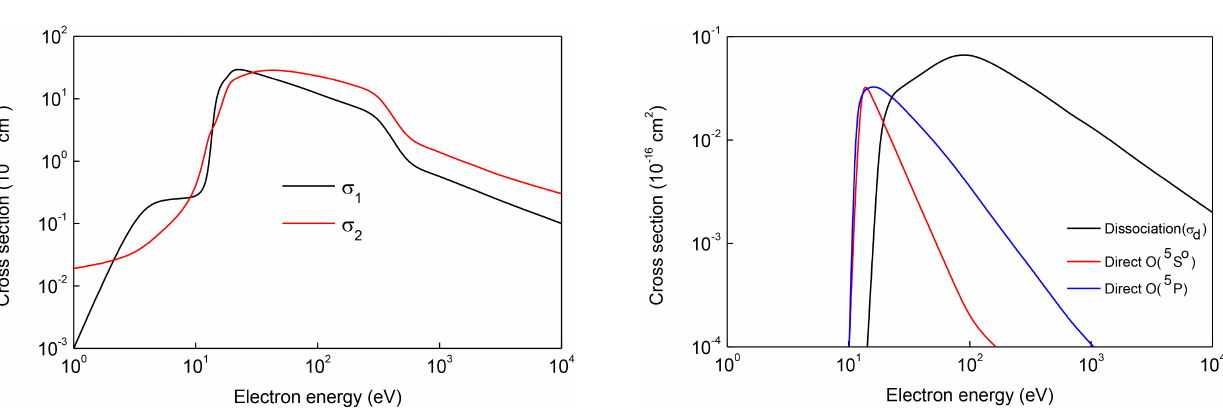
Figure 4. Total inelastic electron impact cross section versus elec- tron energy for atomic oxygen ( σ 1 ) and molecular oxygen ( σ 2 ) .